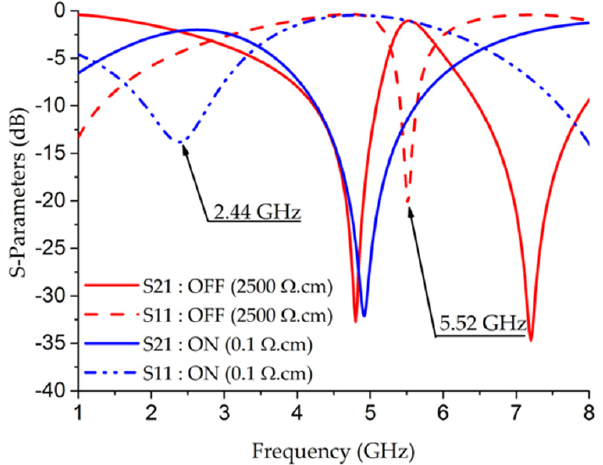
Figure 5. HFSS TM -simulated results of switchable DBR 1 in the OFF and ON states.